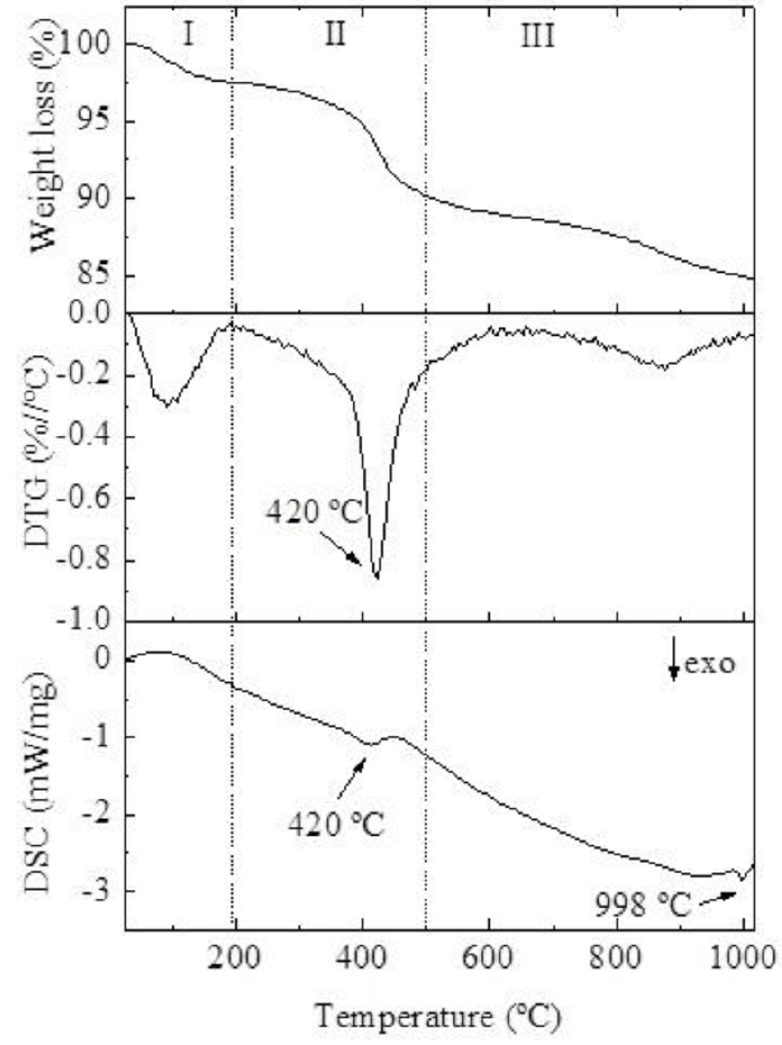
Figure 6. TG, DTG, and DSC curves of the